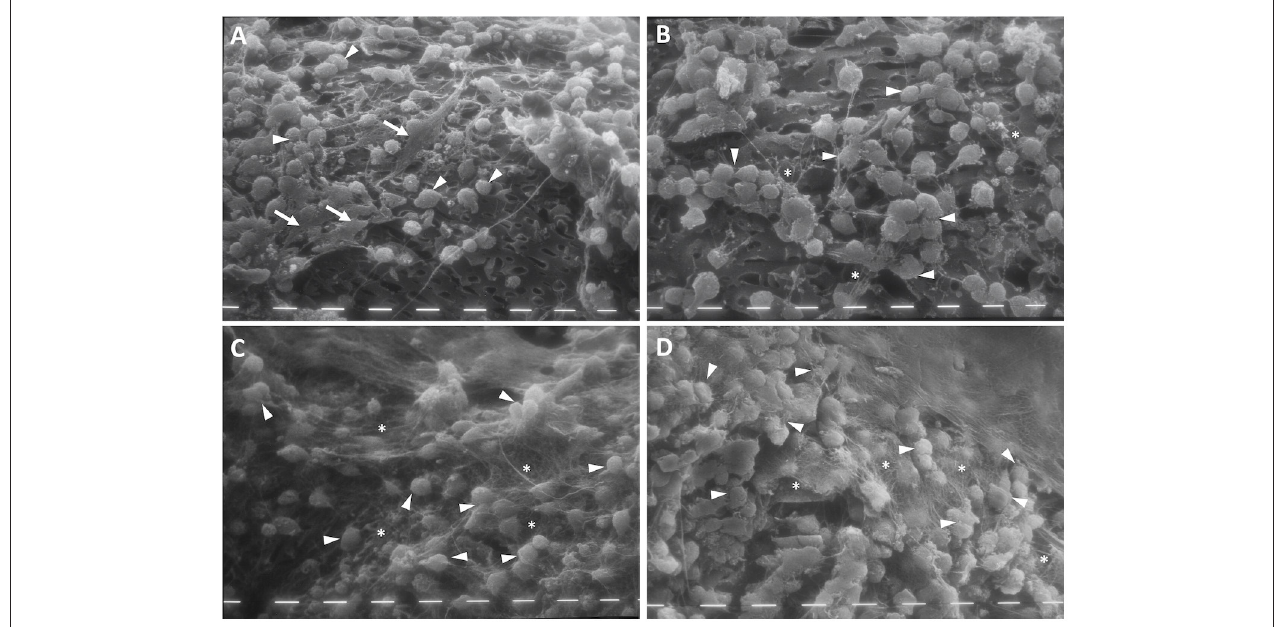
FIGURE 2 | Scanning electron microscopy (SEM) of chitosan scaffold (A,C) and chitosan scaffold prepared with hyaluronic acid (HA) (B,D) with chondrocytes after 2 weeks of culture with FBS (A,B) and PL (C,D) . White arrows: fibroblast-like cells; white tips: round cells; white stars: filaments of matrix. Scale bar = 10 µ m.